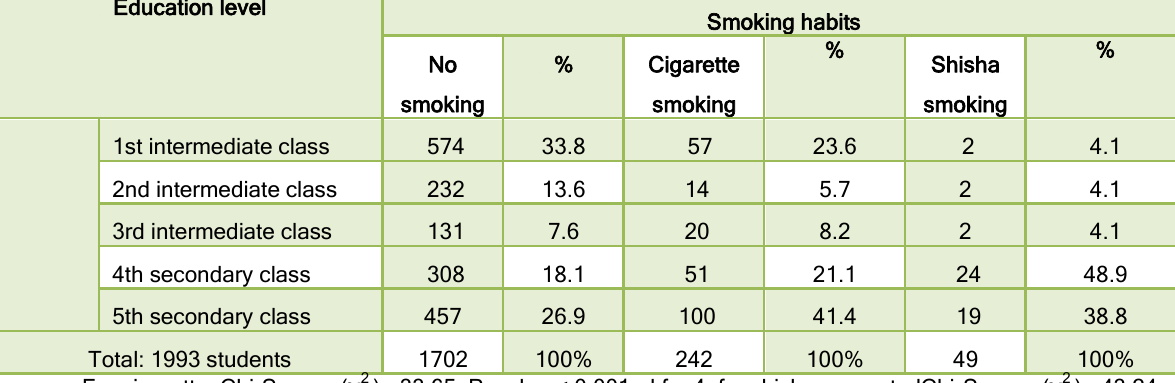
Table (1):The effect of education level on the prevalence of smoking habitsamong students.